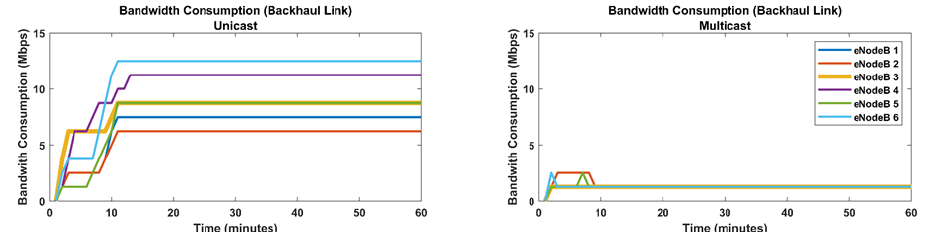
Figure 4. Bandwidth consumption at backhaul link unicast vs.